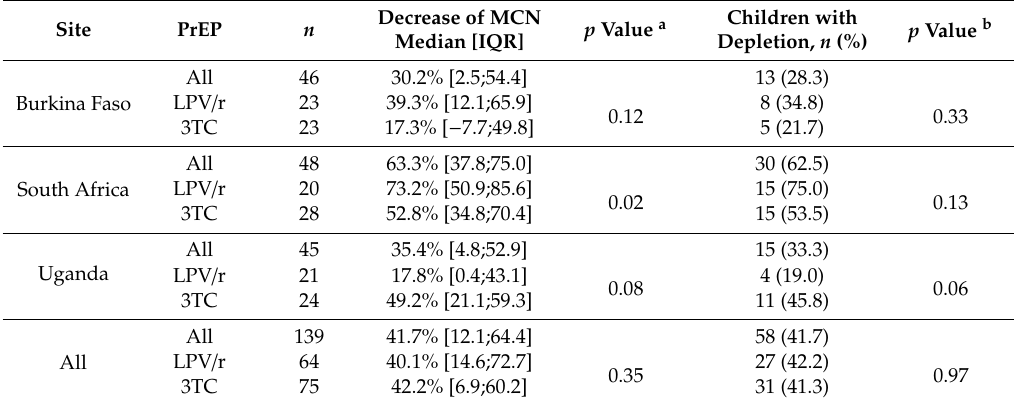
Table 4. Variation of mtDNA copy number per cell (MCN) and number of children with mtDNA depletion ( ≥ 50% reduction) after one year of PrEP by study site.